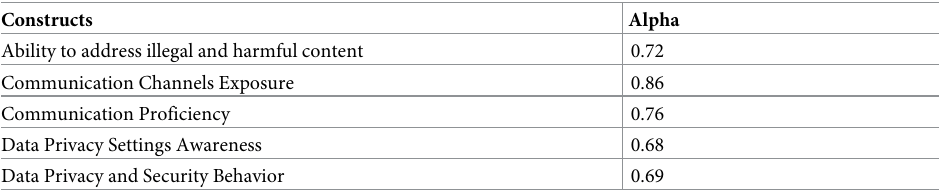
Table 1. Reliability of